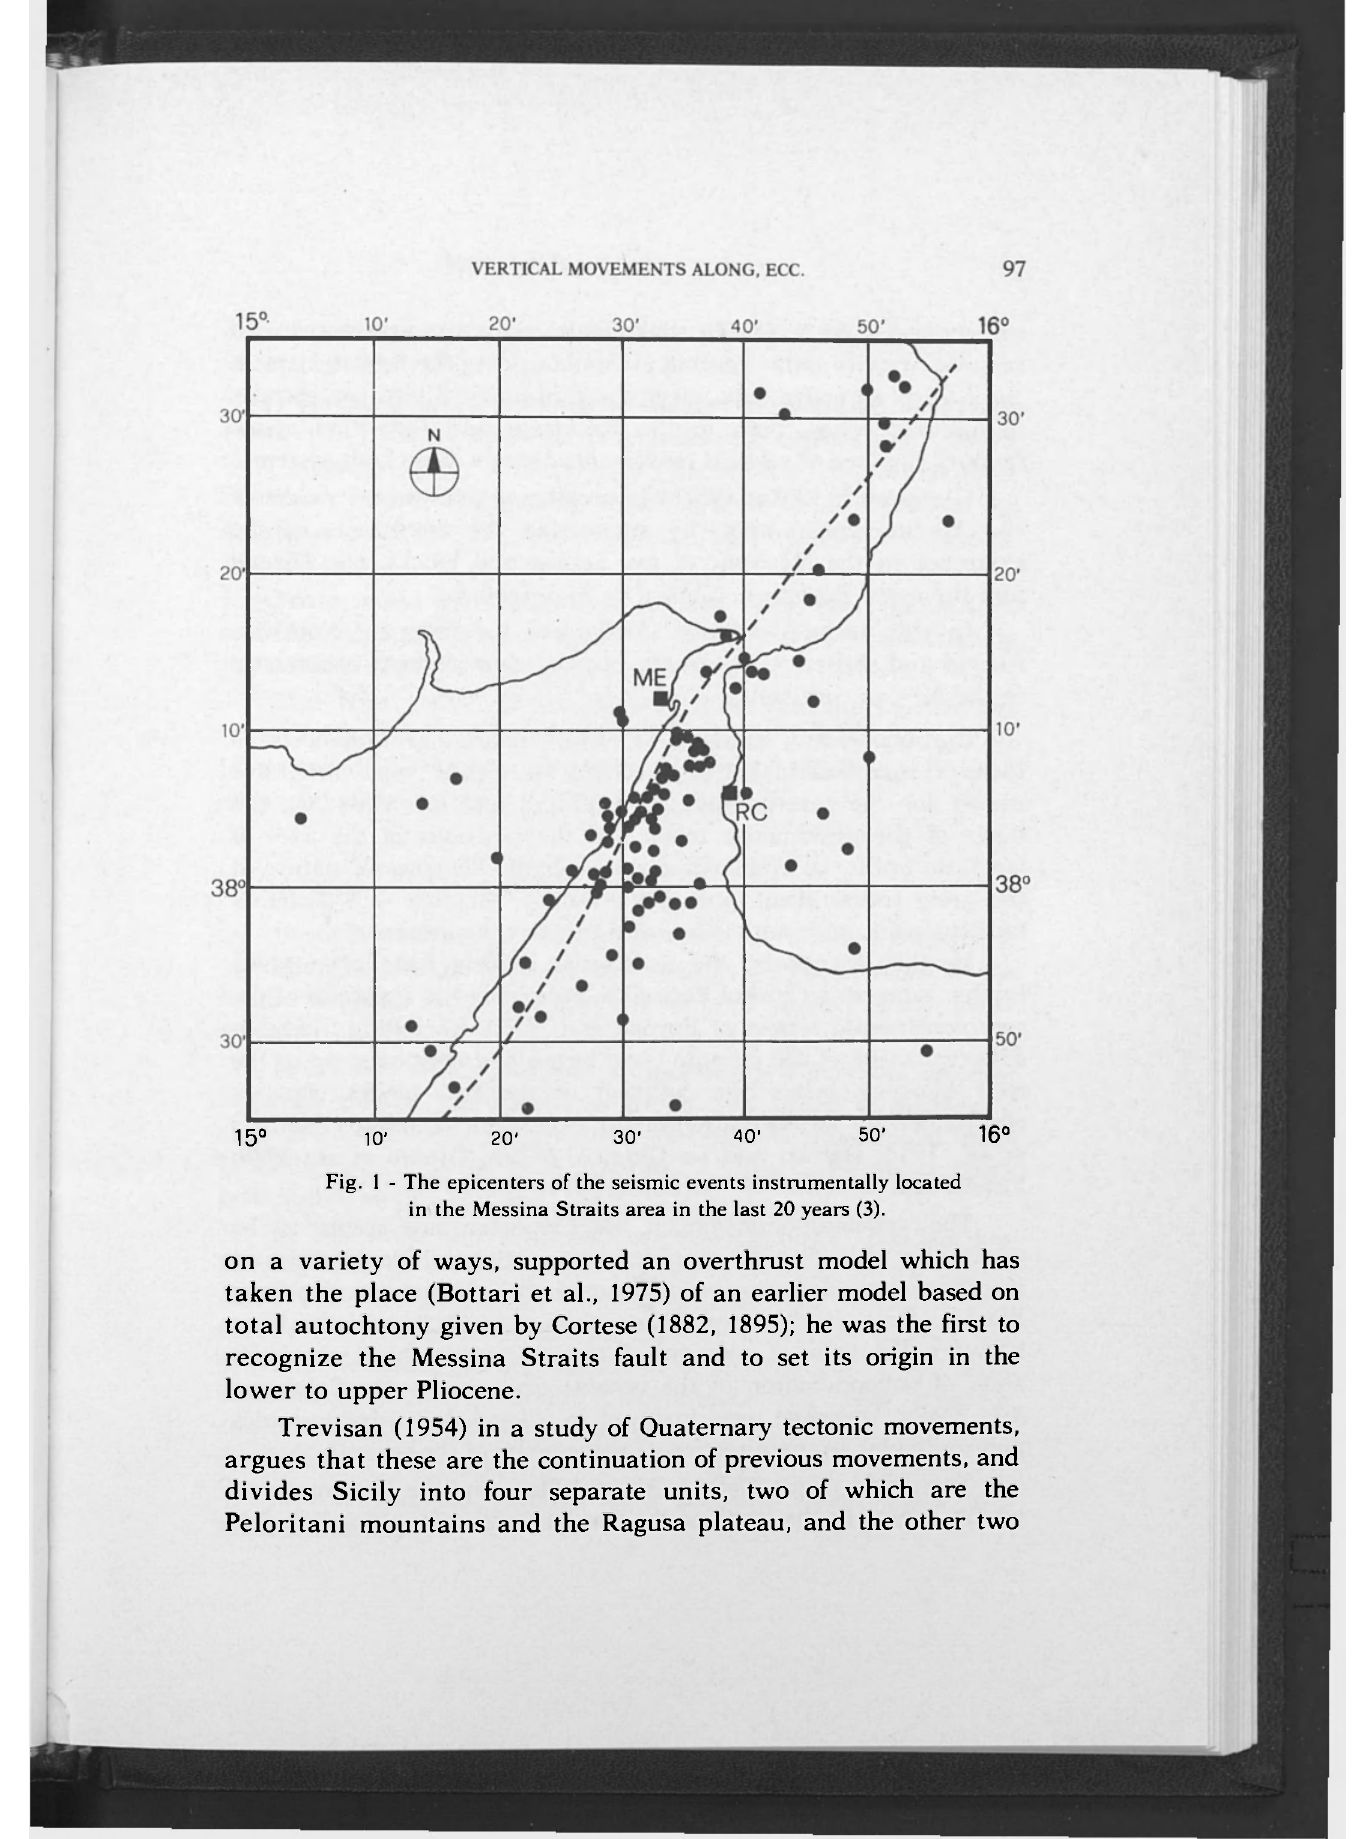
Fig. 1 - The epicenters of the seismic events instrumentally located in the Messina Straits area in the last 20 years